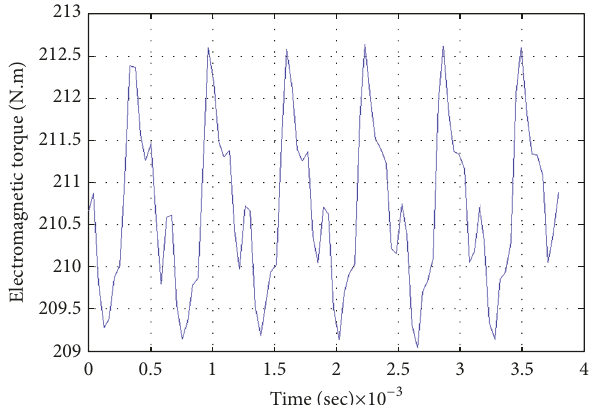
Figure 5: Electromagnetic torque simulation waveform at and sav